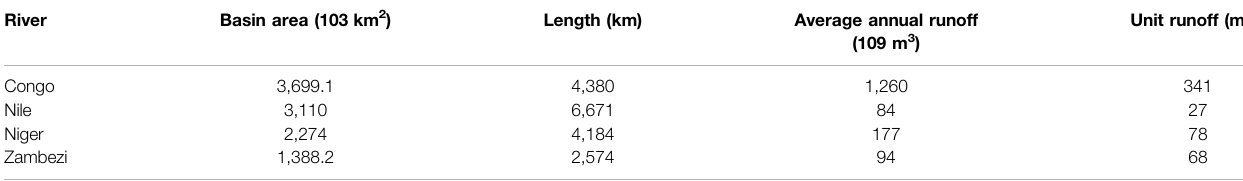
TABLE 1 | The main characteristics of the four largest rivers in Africa adapted from Karyabwite (2000) and Hirji et al. (2002). River